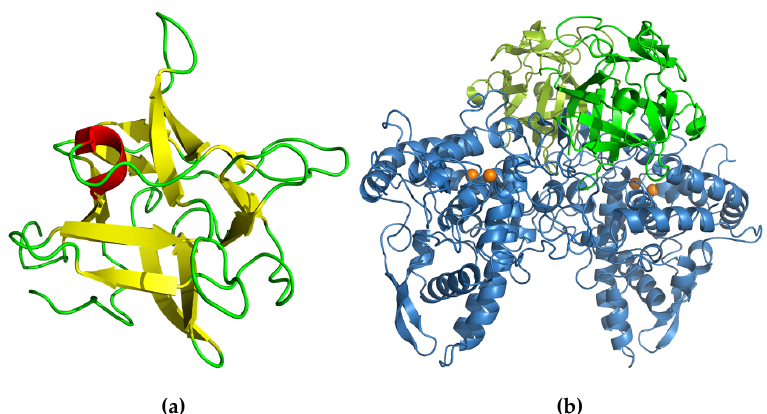
Figure 6. Cartoon presentation of the crystal structure of ( a ) Abmb (PDB ID: 5EHA) and ( b ) the tetrameric complex of PPO3–Abmb (PDB ID 2 × 9Y). In the PPO3–Abmb complex, the tyrosinase is at the bottom, while the Abmb molecules are at the top. The structure was obtained from the Protein Databank. The three-dimensional structure figure was prepared using PyMoL [44].